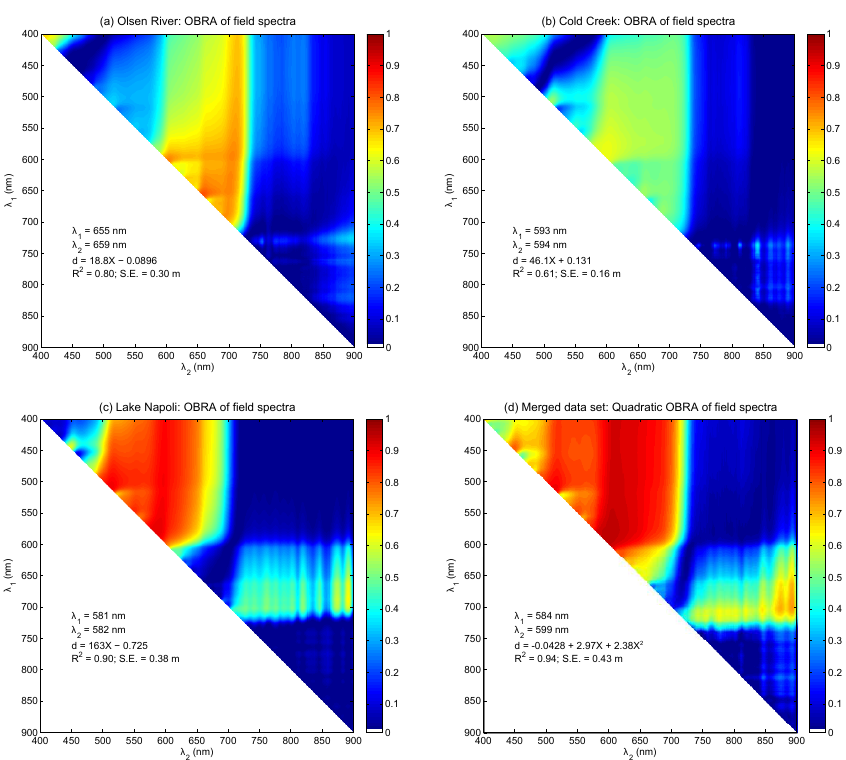
Fig. 3. Optimal band ratio analysis (OBRA) of field spectra for each study site and for a merged data set aggregated across the three sites.